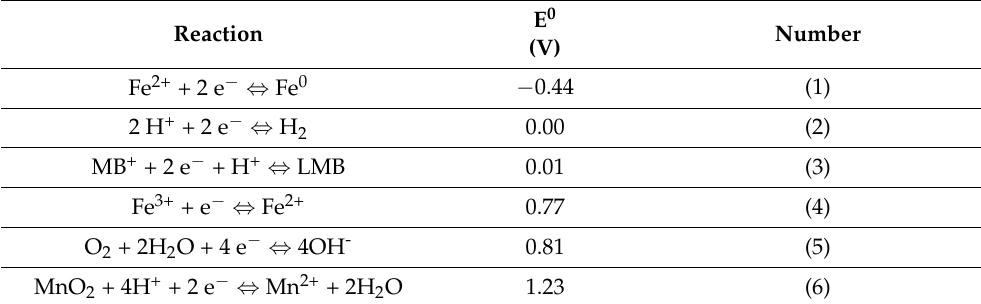
Table 1. Electrode potentials of redox reactions relevant for the discussion in this study (modified after Reference [17]). MB + is the cationic methylene blue (MB), and LMB is its colorless reduced form.